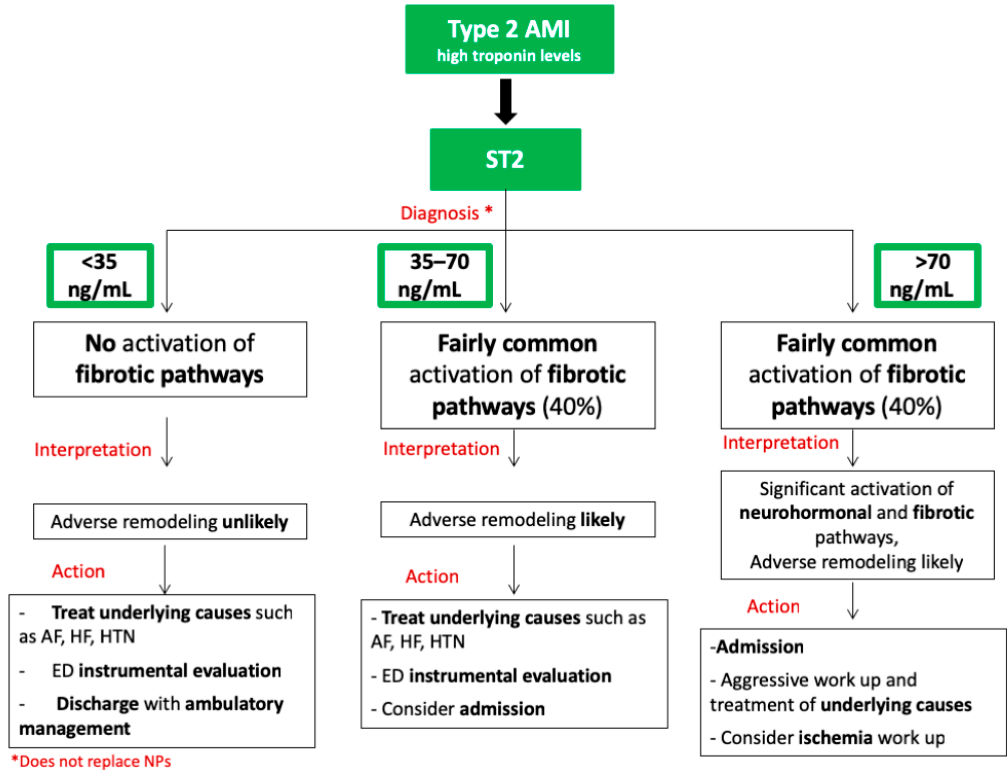
Figure 3. Flowchart summarizing sST2 aided therapeutic decision-making for patients with type 2 myocardial infarction. In patients with type 2 acute myocardial infarction (AMI) and elevated troponin levels, sST2 levels can help to identify 3 classes of patients. If sST2 < 35 ng/mL, adverse remodeling is unlikely. In patients with 35 ≤ sST2 ≤ 70 ng/mL, adverse remodeling is more likely, and patients could benefit from antifibrotic therapies. If sST2 > 70 ng/mL, a significant activation of neurohormonal and fibrotic pathways is likely, requiring aggressive anti-remodeling therapies. Suggested actions for each class of patients are shown in the lower panels. 4. Conclusion In conclusion, sST2, represents, especially when combined with NPs, troponins, and clinical variables, a promising tool that could improve the risk stratification and diagnostic–therapeutic work-up of patients admitted to the ED. Therefore, in this review, we are suggesting a sST2-assisted patient stratification approach in three clinical scenarios (i.e., ADHF, T1MI, and T2MI), whose clinical usefulness should be validated in larger prospective clinical studies. However, we are confident in our conclusion that sST2 plasma levels above 70 ng/mL seem to be associated with a significant activation of both neurohormonal and fibrotic pathways and can help to identify those patients that are affected by ADHF, type 1, and type 2 AMI that are at increased risk of adverse LV remodeling. Serial assessment of sST2 should also be considered for a better management of patients and more appropriate therapeutic decisions, since clinical data suggest that the kinetics of sST2 plasma levels can discriminate patients with different outcomes. Author Contributions: Each author has participated enough in this work to take public responsibility for its content and has given substantial contributions. All Authors have reviewed and approved the manuscript. A.A. and A.S.M. gave substantial contributions to the conception of the review. A.A., A.P., L.P. and A.P.B. contributed to the writing and the original draft preparation of the manuscript. M.I., M.E., G.S. and A.S.M. gave contributions to the revision and editing of the submitted version. A.S.M. took care of the supervision. Funding: This research received no external funding.